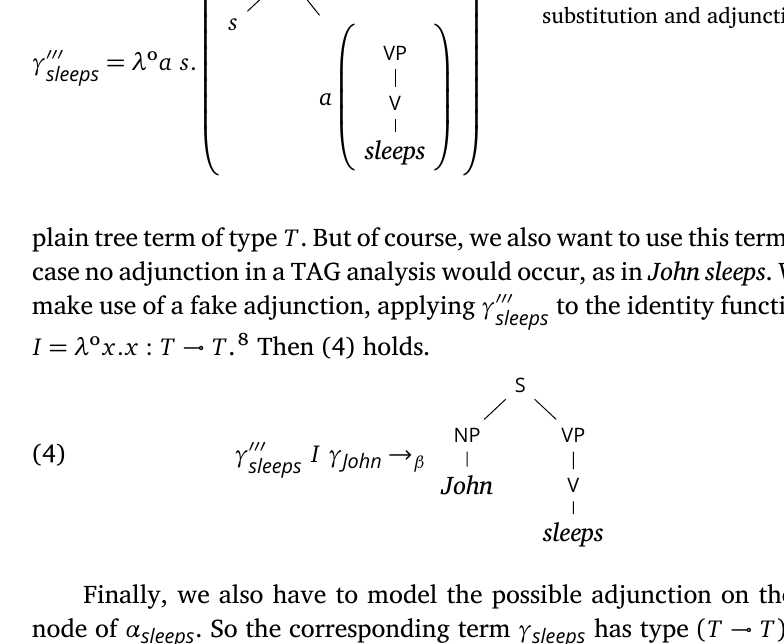
Elementary tree representation available to substitution and adjunction